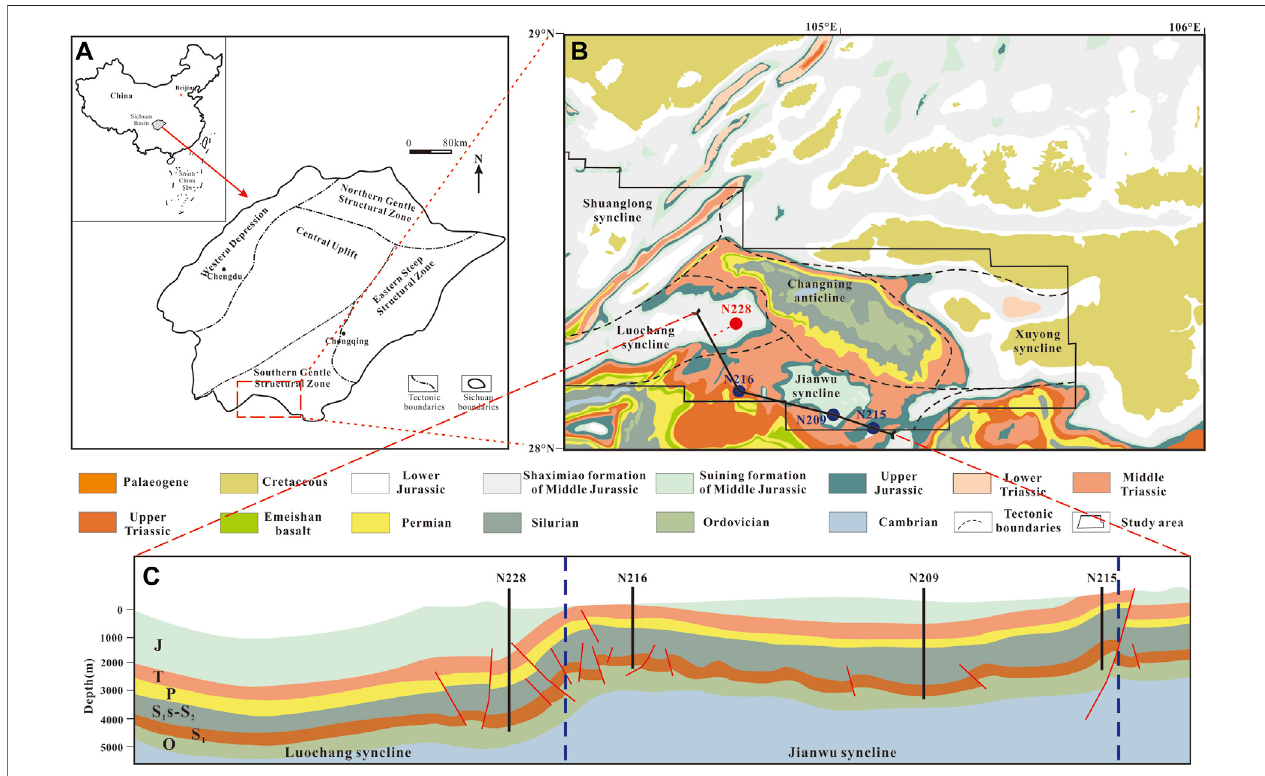
FIGURE 1 | (A) Location of Sichuan Basin in China and the Changning area of Sichuan Basin; (B) sub-tectonic units and the surface geological map of the Changning area, in which the wells N228, N209, N215, and N216 are located; (C) geological section of Luochang and Jianwu synclines. J, T, P, S 1 s-S 2 , S1, and O are the Jurassic, Triassic, Permian, and other formations of Silurian except for Longmaxi Formation, Longmaxi Formation of early Silurian, and Ordovician